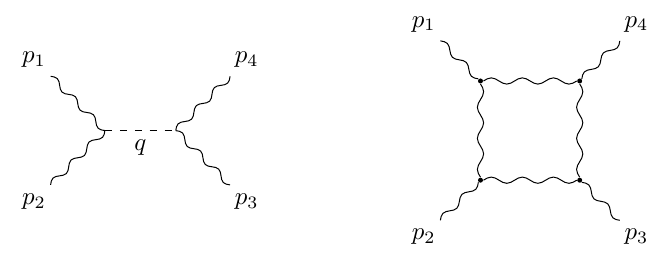
Figure 1 . On the left we have the tree-level axion exchange, which by a Green-Schwarz mechanism matches the one-loop four-point amplitude on the